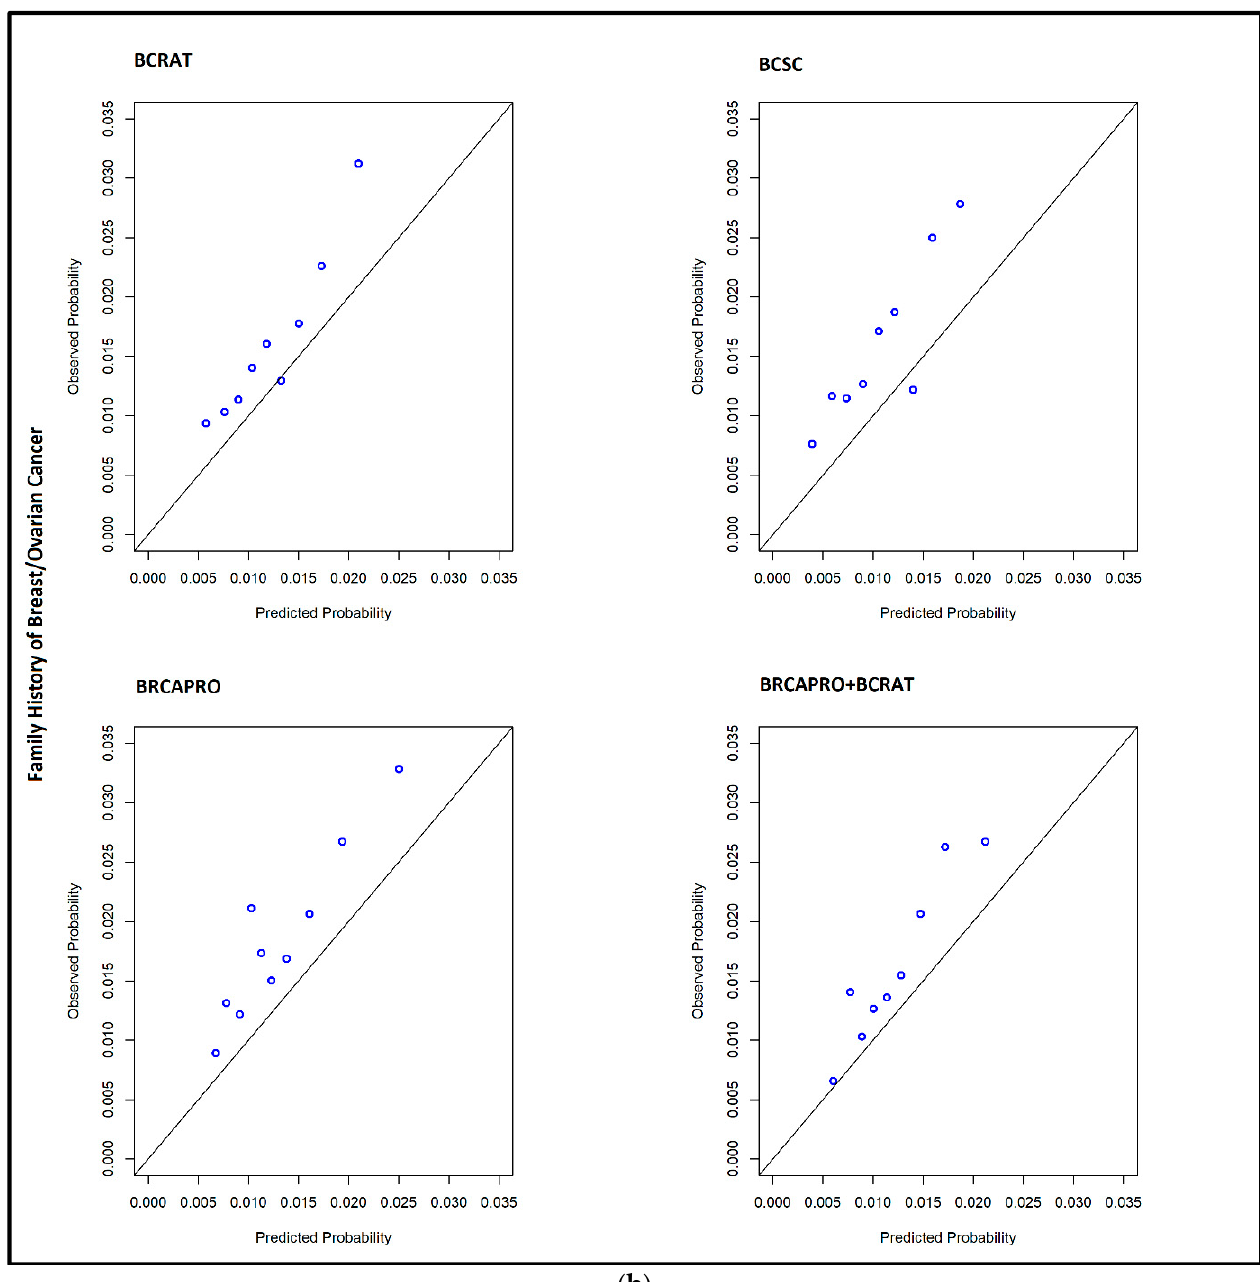
Figure A1. ( a ) Calibration curves for four models for individuals with no family history of breast cancer. ( b ) Calibration curves for four models for individuals with a family history of breast cancer. Each point on the figure represents the observed probability of breast cancer ( Y -axis) for each decile of probability of breast cancer predicted by the model ( X -axis). The diagonal line indicates perfect agreement between predicted and observed probability of breast cancer.